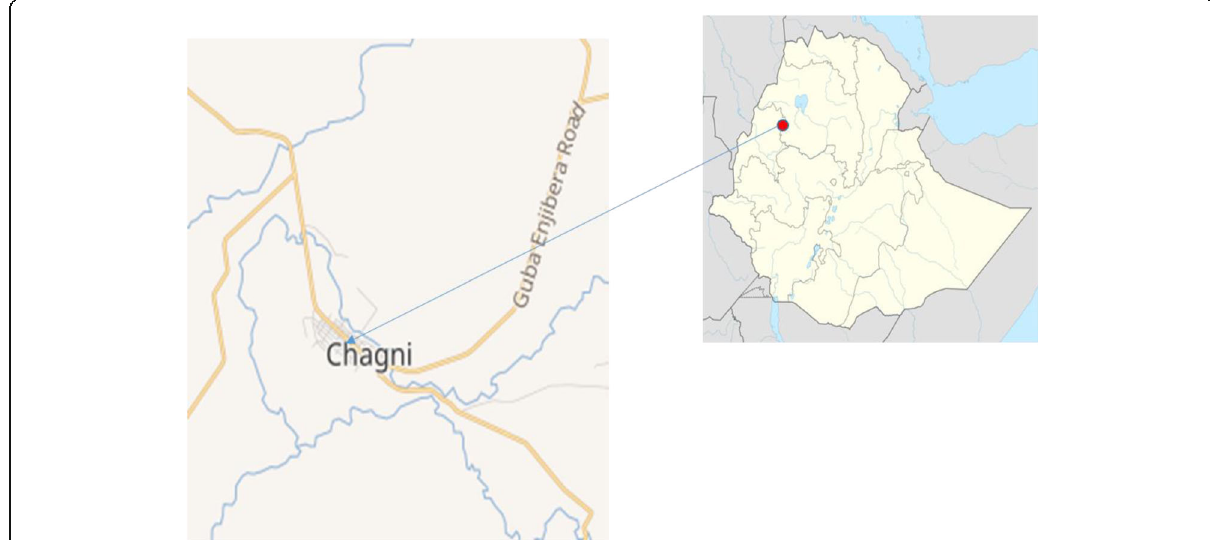
Fig. 1 Map and location of the study area in Chagni District, Northwest